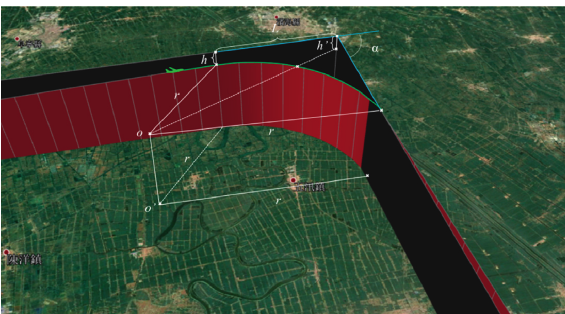
Figure 1: The diagram of the aircraft turning (3D): The blue line is the planned trajectory, and the green line is the trajectory predicted by the BADA.